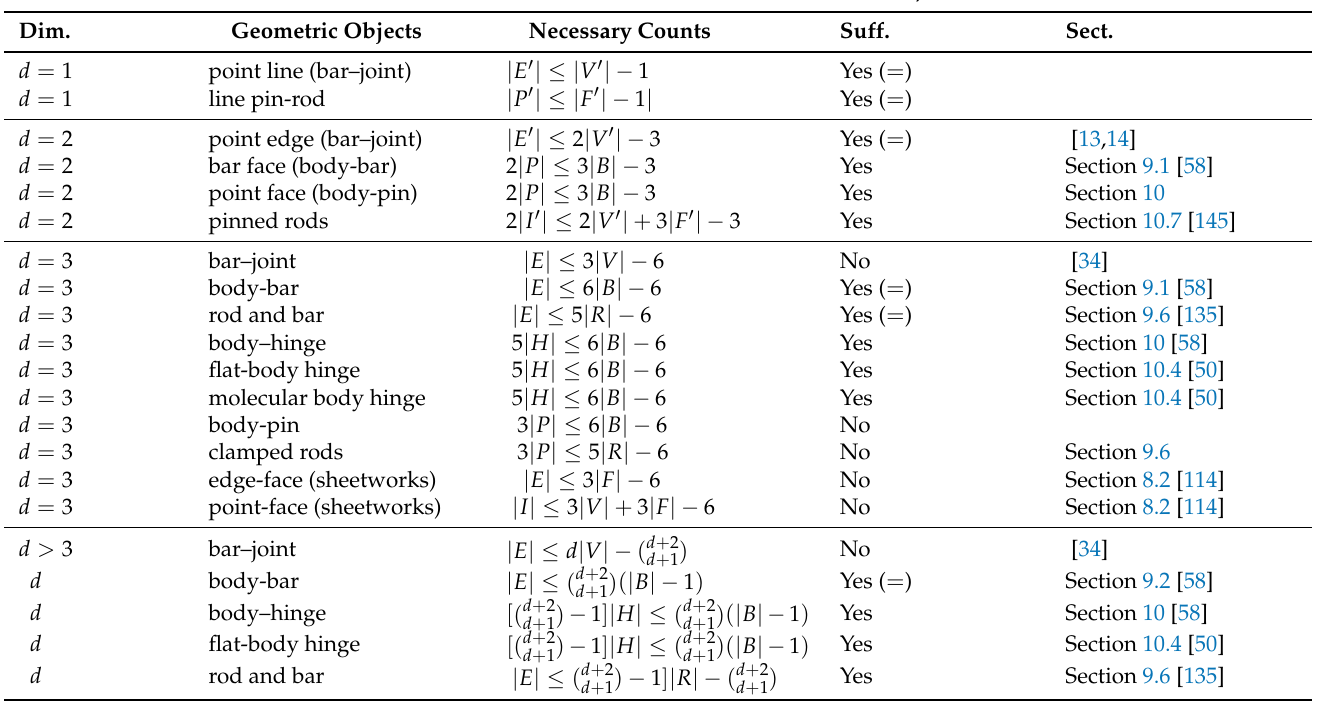
Table 1. Structures with distance constraints, and necessary counting conditions. Pins and clamps mean shared vertices of larger bodies. Table of Geometric Structures and Distance Constraints: Euclidean, Minkowski